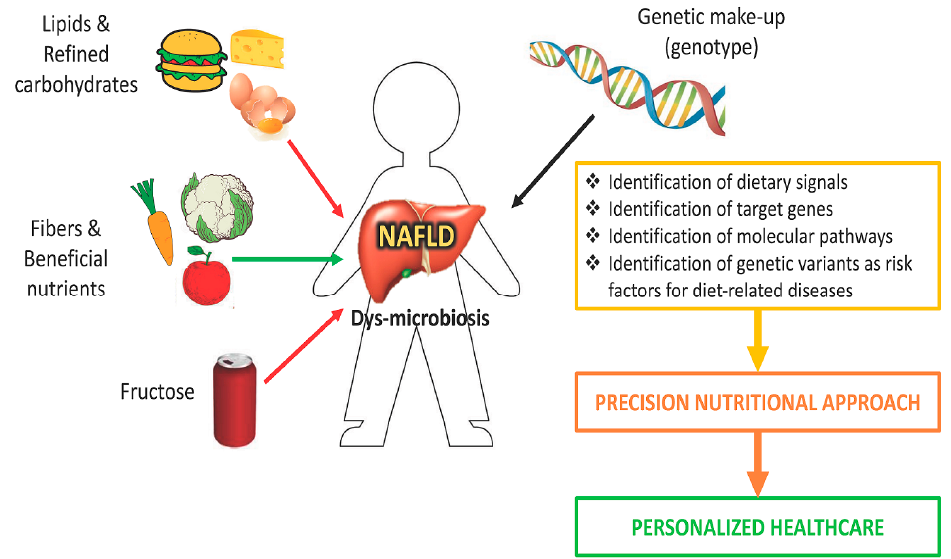
Figure 2. A nutrigenomic approach for nonalcoholic fatty liver disease (NAFLD). Dietary intervention based on knowledge of nutritional requirement, nutritional status, and genetic makeup (personalized medicine) can be used in the management of NAFLD patients.